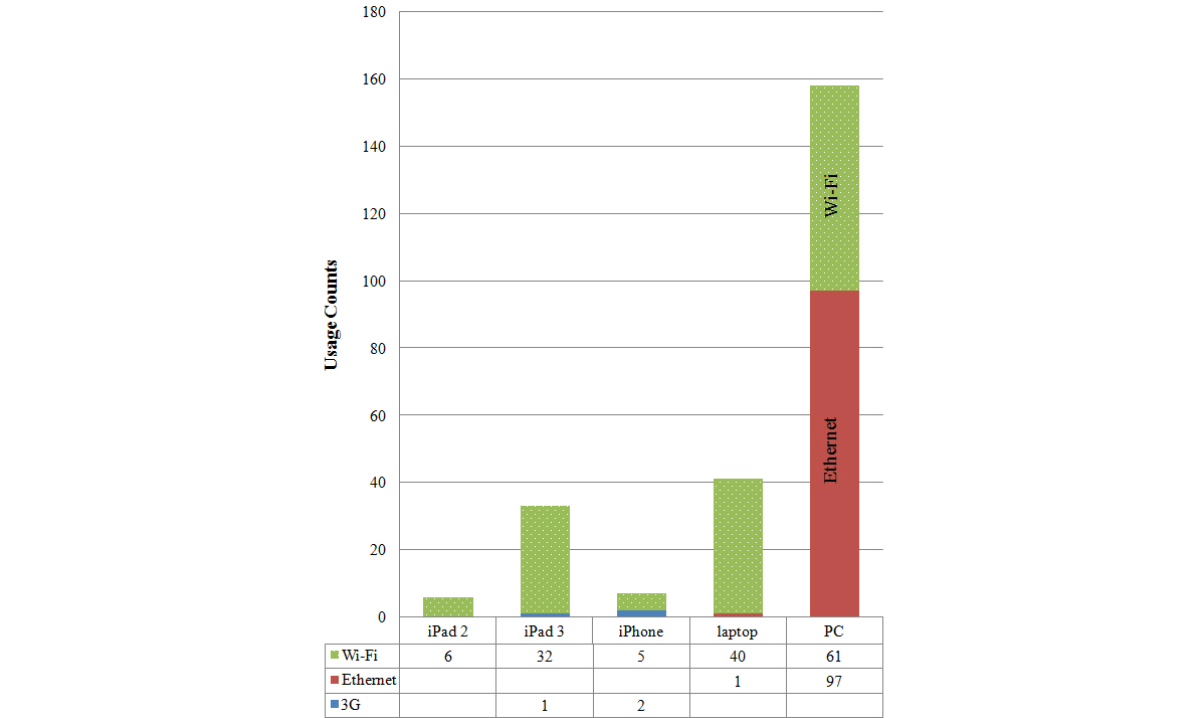
Figure 2. Usage counts are shown broken down by device and Internet connection